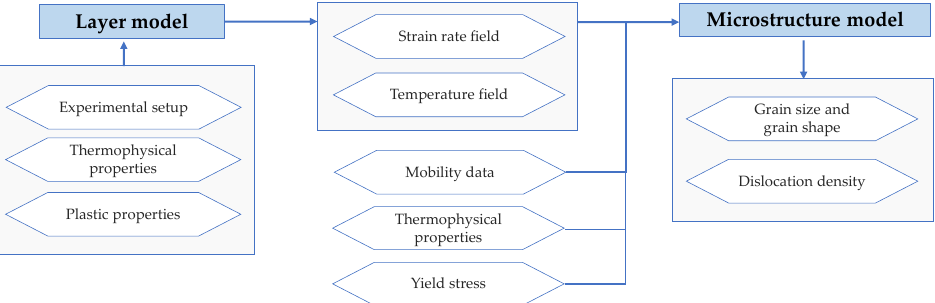
Figure 1. General input and output parameter for hot rolling